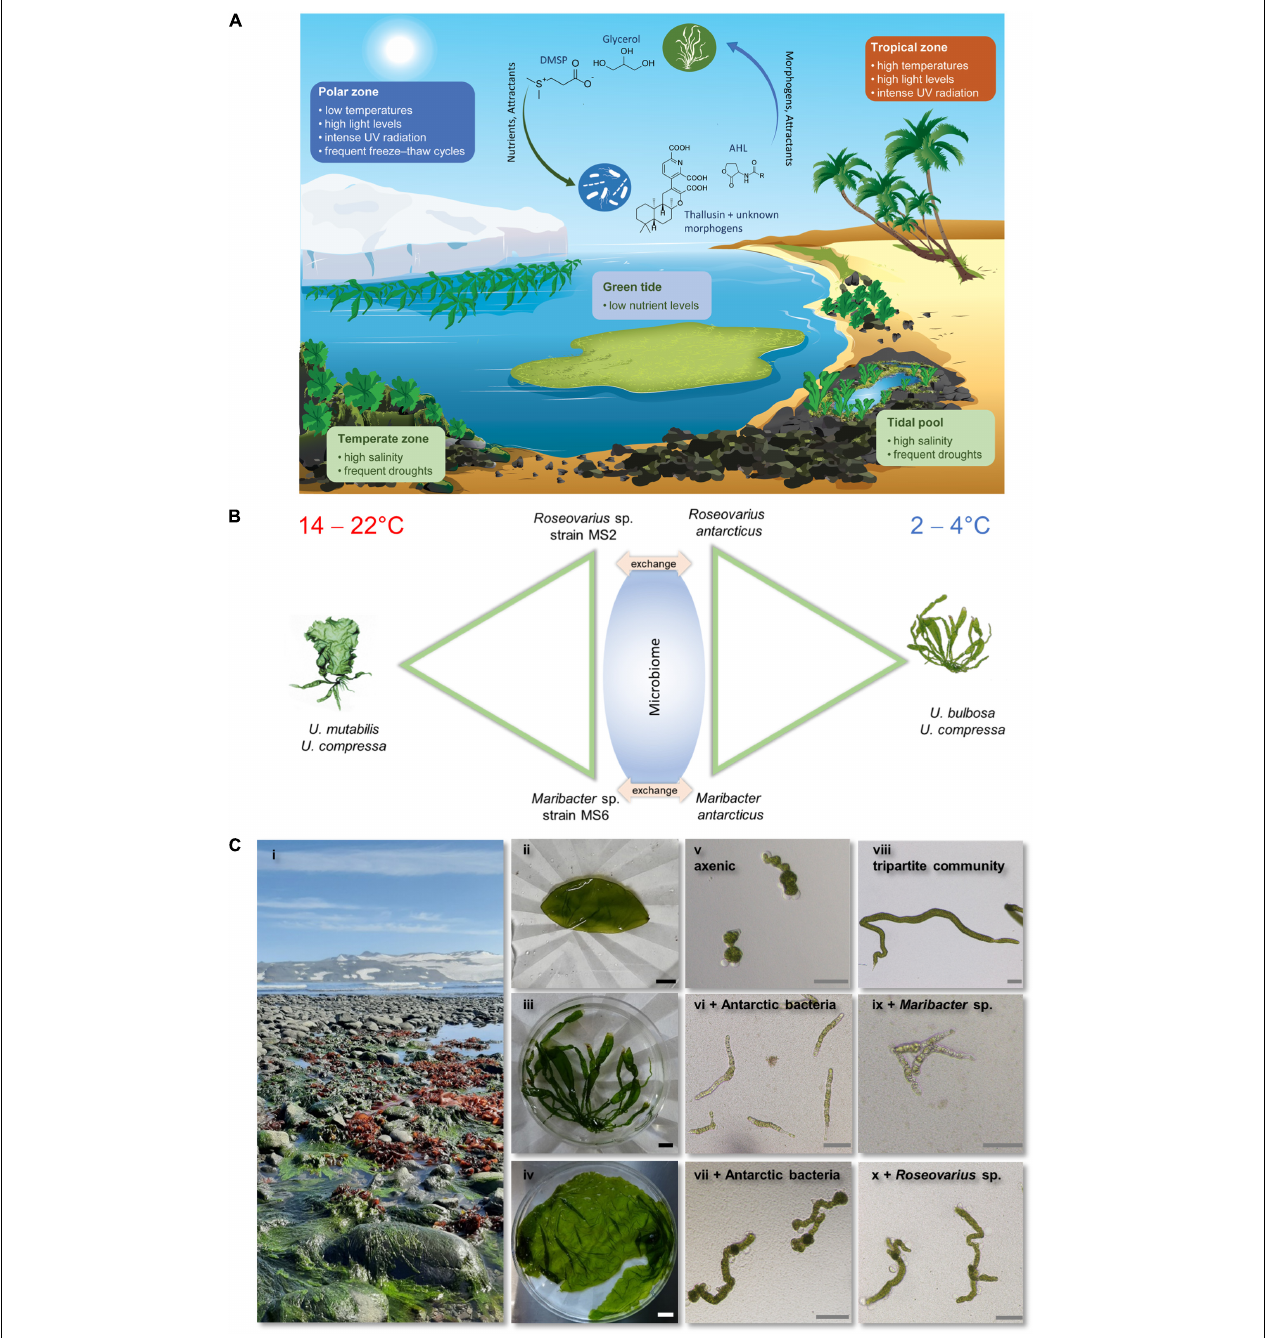
FIGURE 1 | (A) Ulva is a cosmopolitan seaweed that inhabits a range of gradient ecosystems. The physiological mechanisms of niche adaptation of Ulva to extreme environmental conditions, such as those in polar regions, that disrupt cellular activities in most organisms and the structure of its community are yet to be investigated in detail. A range of compounds has been identified that modulate the niche adaptation and modulate abiotic stresses. Amino acids, e.g., proline, and their derivatives such as betaine and zwitterionic metabolites, such as DMSP, are produced under cold stress. Morphogens (thallusin), attractants (DMSP, N-acyl homoserine lactones [AHLs with various acyl side chains R]) and nutrients (glycerol) mediate the bacteria-macroalgae interactions. (B) The “symbiotic toolkit” of Ulva applies a reductionist strategy under controlled conditions to decipher the microbiome-dependent adaptation to environmental stimulus in Ulva . A designed microbiome can be tested in cross-exchange experiments using freshly isolated straits from Antarctica or reference strains such as Maribacter antarcticus (DSM 21422) and Roseovarius antarcticus (DSM 102249). (C) Ulva spp. can preserve their growth, reproduction, and metabolic processes despite harsh environmental conditions, e.g., (i) in polar region in the Potter Cove on King George Island. Monostroma sp. (ii), Ulva sp. (iii), and Protomonostroma spp. (iv) were found in Antarctica in the summer of 2020. Associated bacteria from these green macroalgae release algal growth- and morphogenesis-promoting factors, which induce normal cell wall and rhizoid formation (vi) as well as cell division (vii) in axenic cultures (v) of U. mutabilis . Controls are shown (viii–x). Photographs (i–iv) were taken with permission from Fromm et al., 2020.